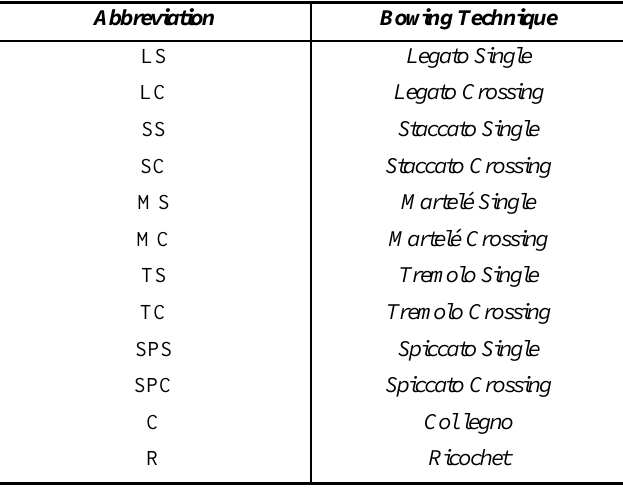
Table 1: The twelve bowing techniques and their mnemonics.